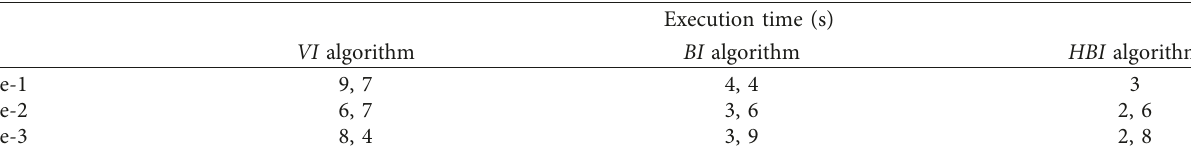
Table 2: Performance of the HBI algorithm.